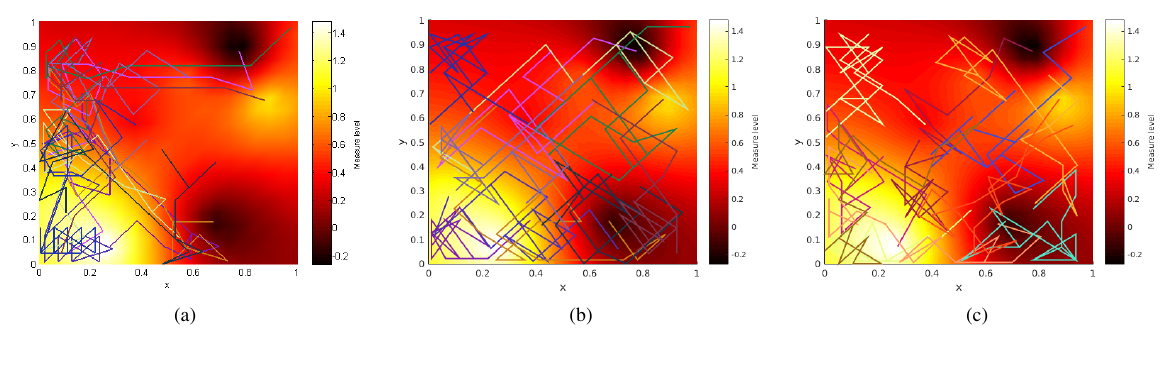
Fig. 9. Coverage effect of parameter s . (a) s = − 10 . Agents have redundant trajectories and some regions remain uncovered. (b) s = − 4 coverage improves but agents still explore redundant zones. (c) s = − 1